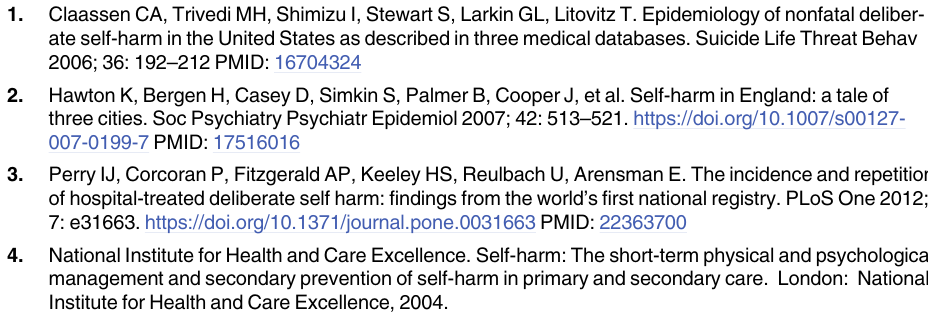
S2 Fig. Adjusted odds ratios by hospital for general admission. S3 Fig. Adjusted odds ratios by hospital for psychiatric admission. S4 Fig. Adjusted odds ratios for by hospital left without being seen/ refuse